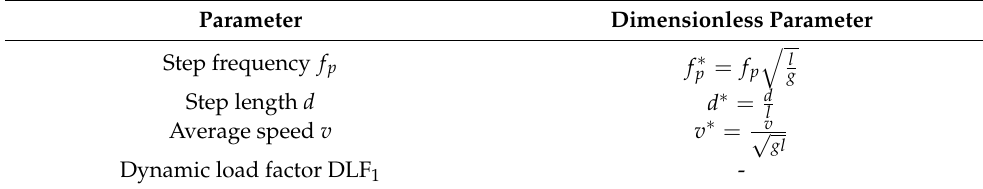
Table 2. Parameters of interest.